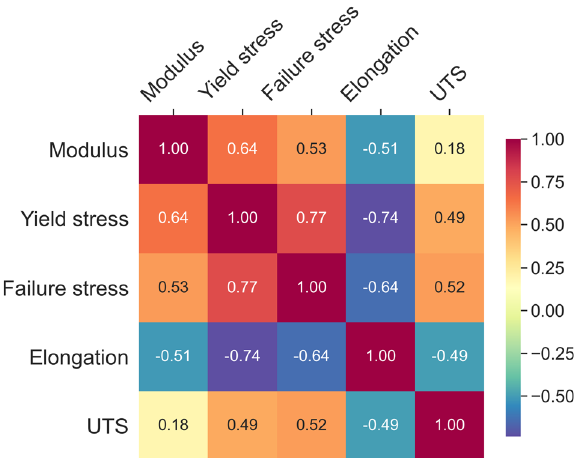
Fig. 4 Correlation matrix of mechanical properties. Pearson correlation coef fi cient de fi ned in ref. 56 is used to quantify the correlation between